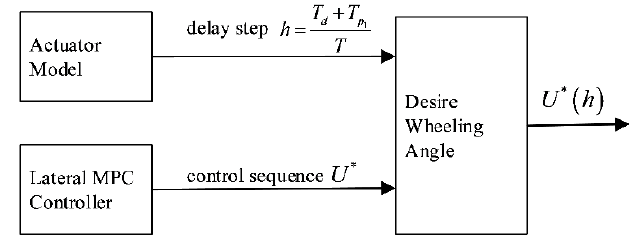
Figure 3. MPC control block diagram based on delay